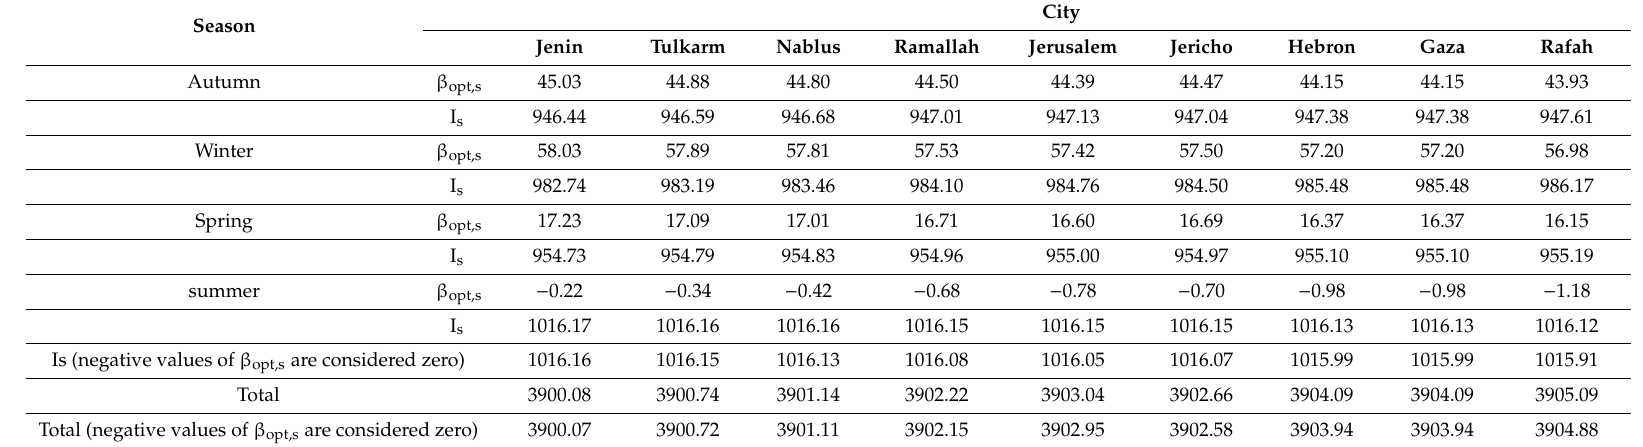
Table 9. The seasonally optimum tilt angles β opt,s and extraterrestrial radiation I s in kWh / m 2 for the main Palestinian cities.